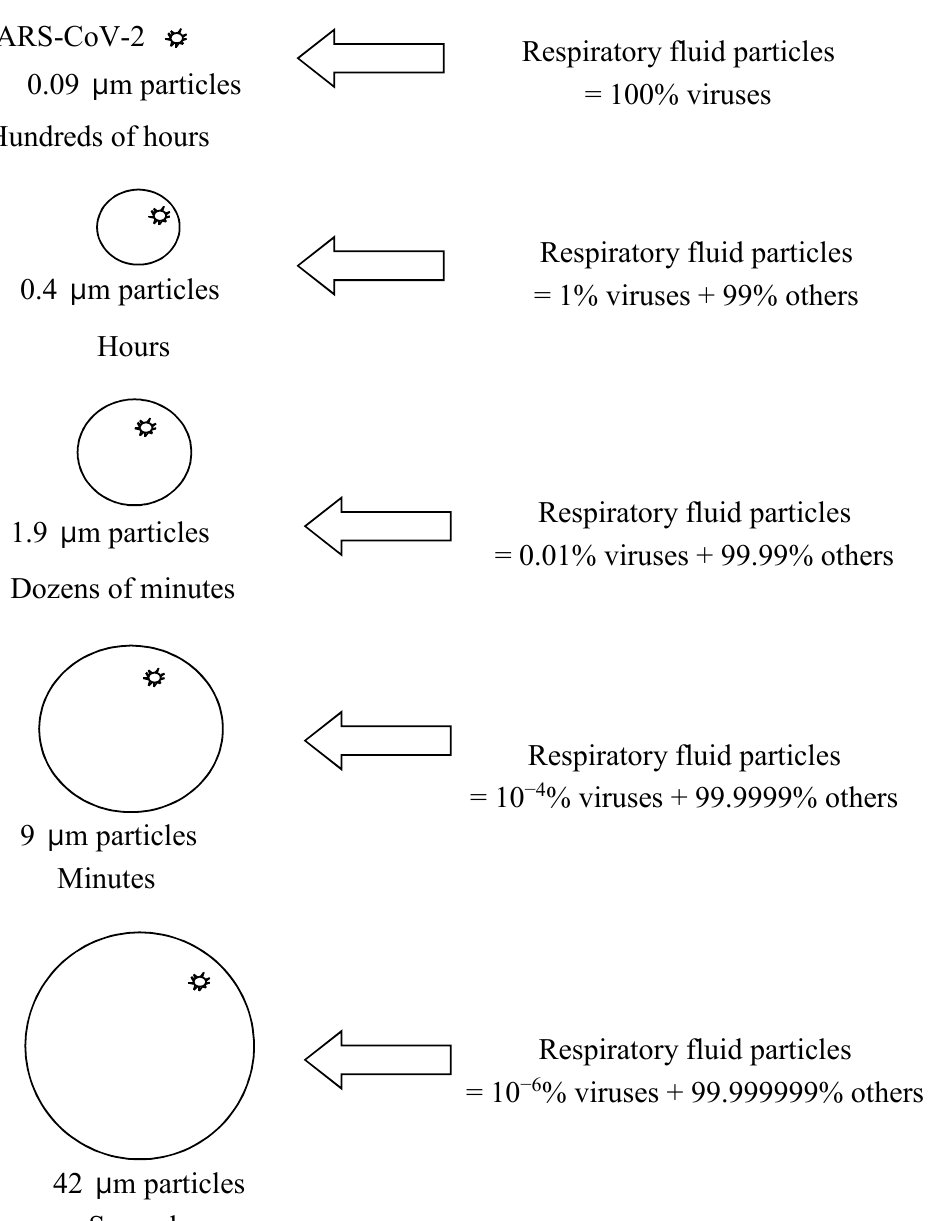
Figure 1. Estimated minimum size of particles (assuming homogenous distribution of viruses in released respiratory fluid particles and virus size of 0.09 µ m) potentially carrying SARS-CoV-2 and corresponding aerosol suspension times.